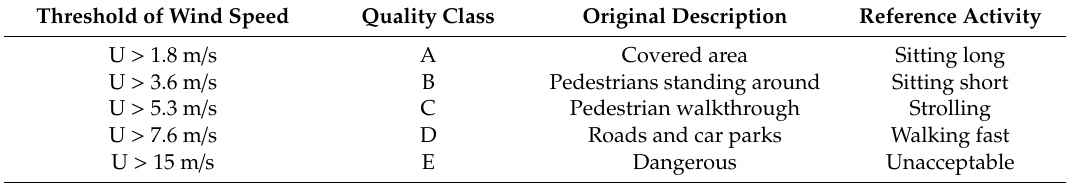
Table 3. Wind speed classification based on pedestrian comfort after Lawson [54].